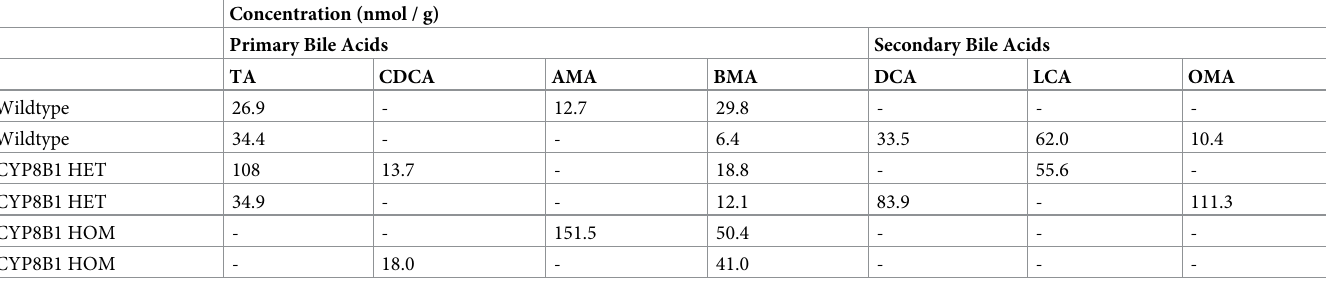
Table 1. Bile acid profiles of conventionally raised wildtype, CYP8B1 heterozygous and CYP8B1 homozygous mice. Concentration (nmol / g)